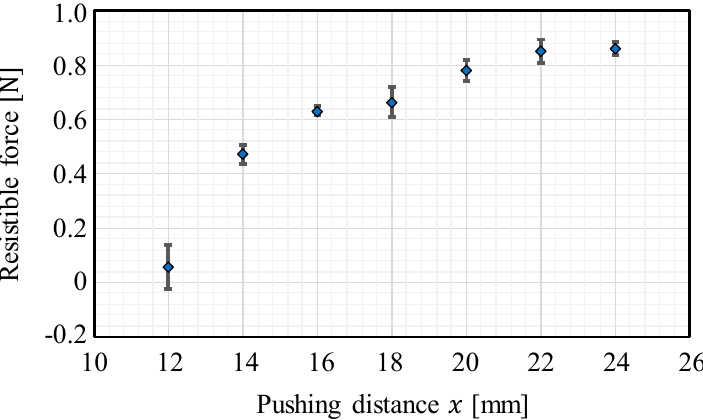
Figure 15. Experimental setup for investigating the resistible force when grasping with various degrees of compression.